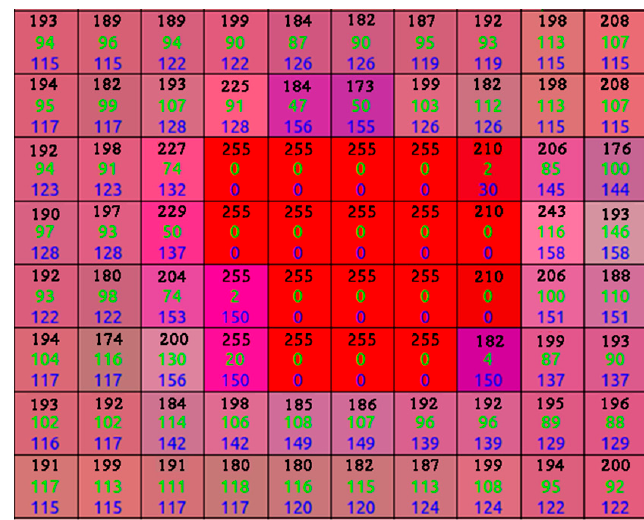
Figure 3. Laser point shown in HSV image using (255, 0, 0).